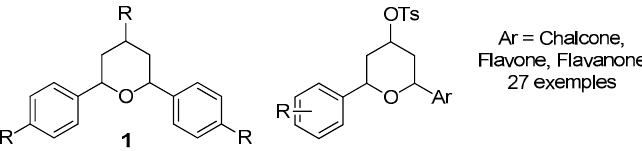
Figure 1. The compound 2,4,6-Diaryltetraydropyran has antiproliferative activity against human cancer cell lines.